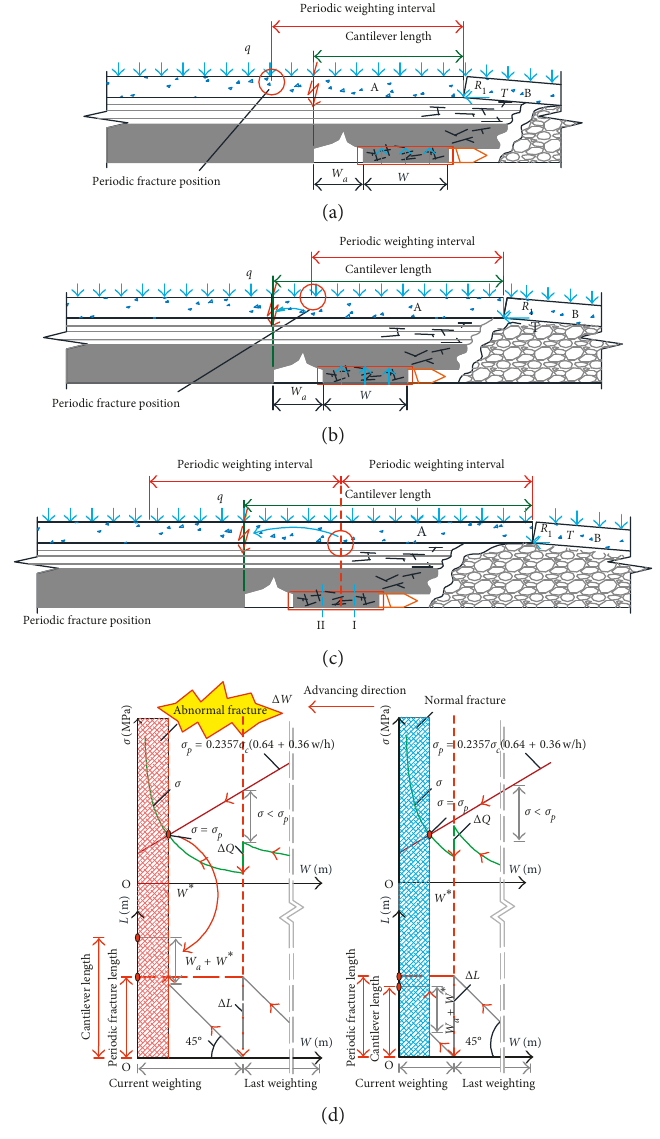
Figure 7: Relative positions of the abandoned roadway and fracture